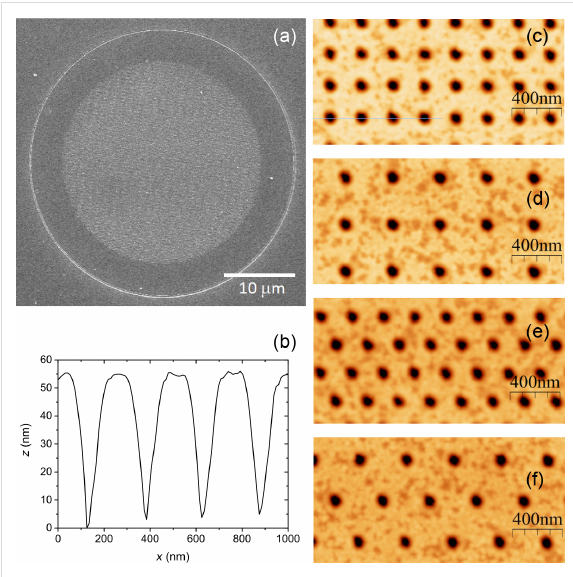
Figure 2: (a) SEM image of the antidot array patterned on the film with 27 nm thickness. (b) Profile obtained from the AFM image correspond- ing to a square array with a hole spacing of 240 nm, in particular along the blue line of image c. Square array with a lattice constant of 240 (c) and 360 nm (d). Hexagonal arrays with a lattice constant of 240 (e) and 360 nm (f).